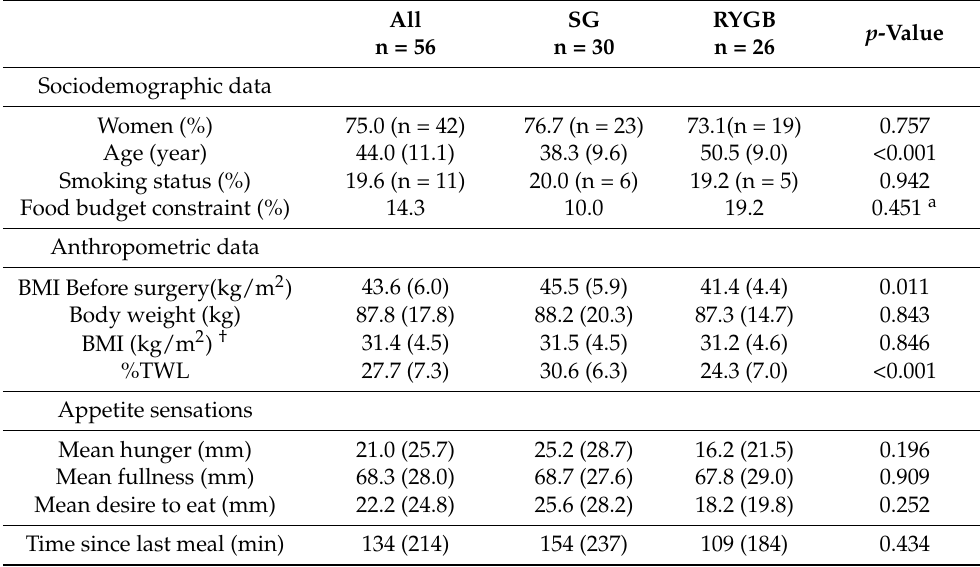
Table 2. Socioeconomic and behavioral characteristics of the 56 included patients according to their operative